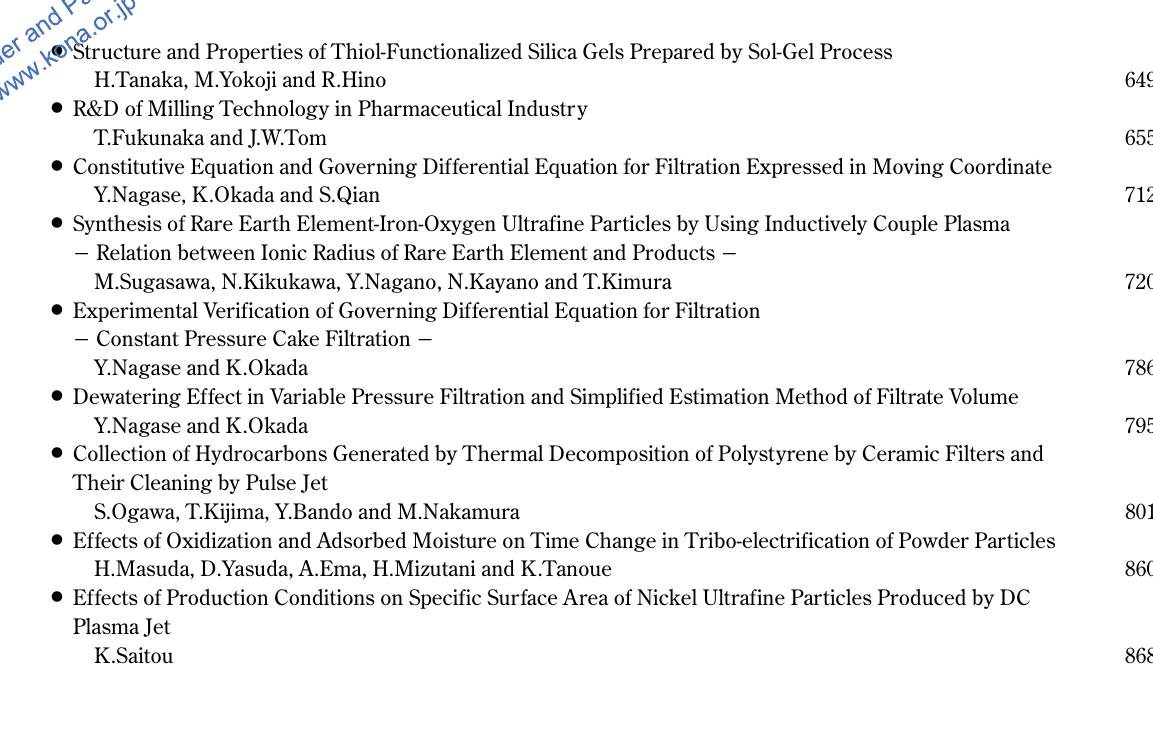
(cid:1) Structure and Properties of Thiol-Functionalized Silica Gels Prepared by Sol-Gel